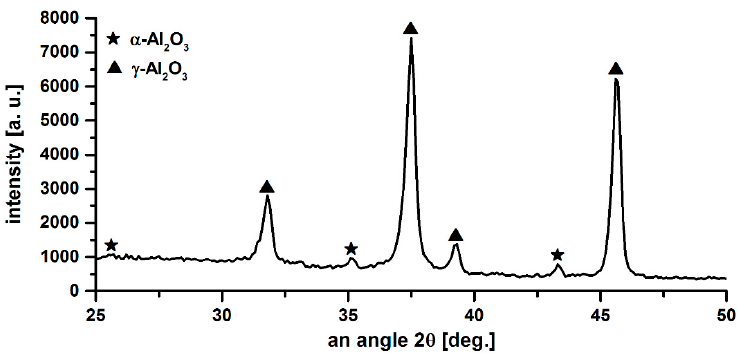
Figure 7. A fragment of the X − ray diffraction pattern of coating on a sample for the stress corrosion test.